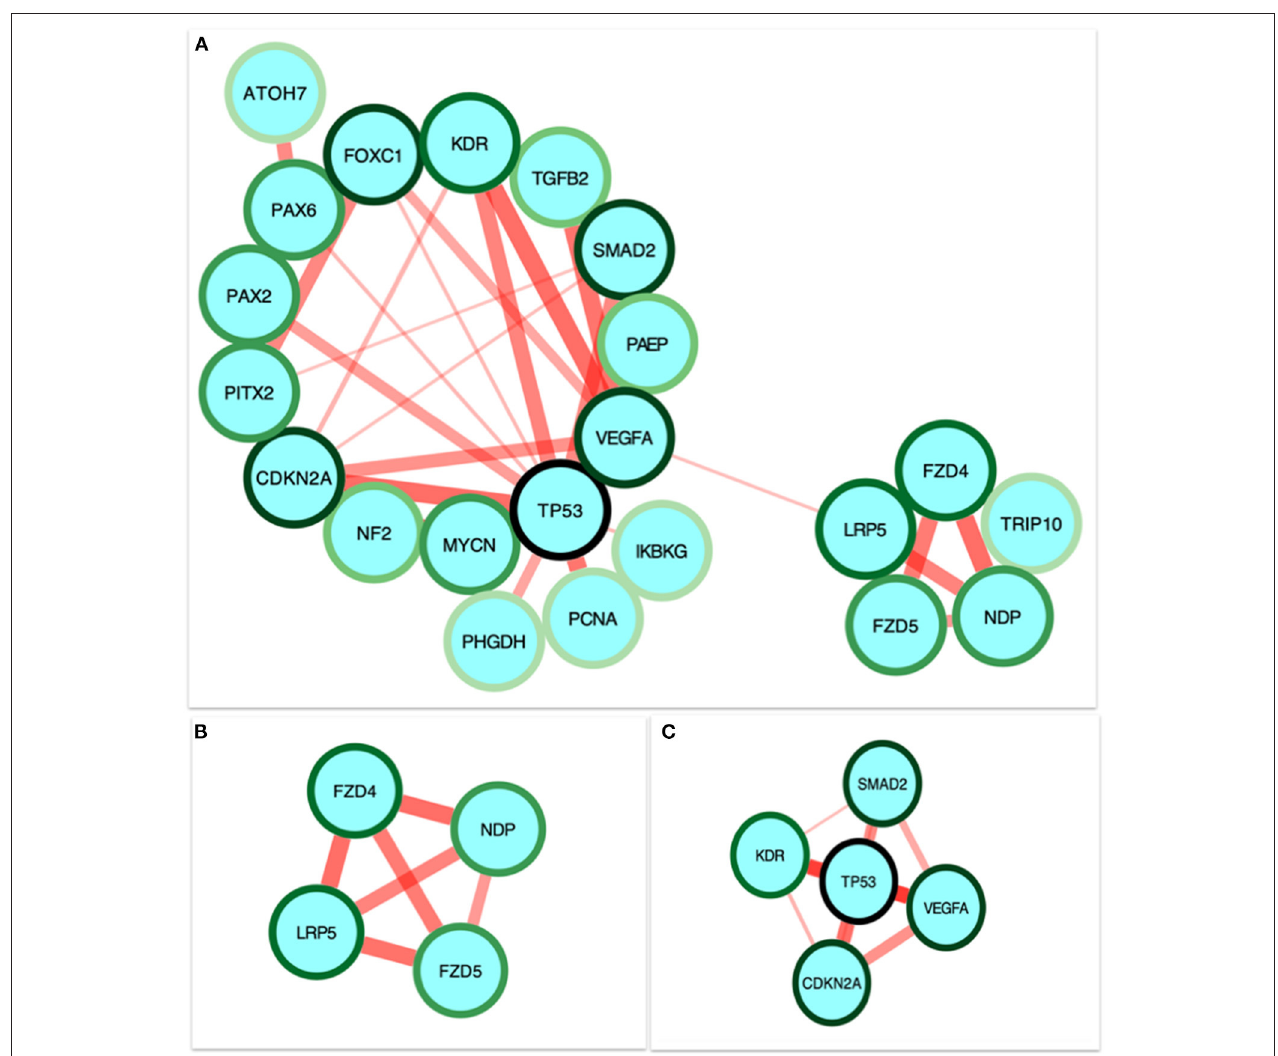
FIGURE 4 | Identification and enrichment analysis of the text mining genes (TMGs). (A) The protein-protein interaction (PPI) network of the 35 target TMGs was visualized using Cytoscape. The gradience of the genes node border color reflects its role in the eye development process (a dark green node border represents the strongest degree of association and a light green node border represents the weakest degree of association). (B,C) The two modules were obtained from the PPI network using MCODE. (B) Module 1, the most significant module with four nodes. (C) Module 2 with five nodes.